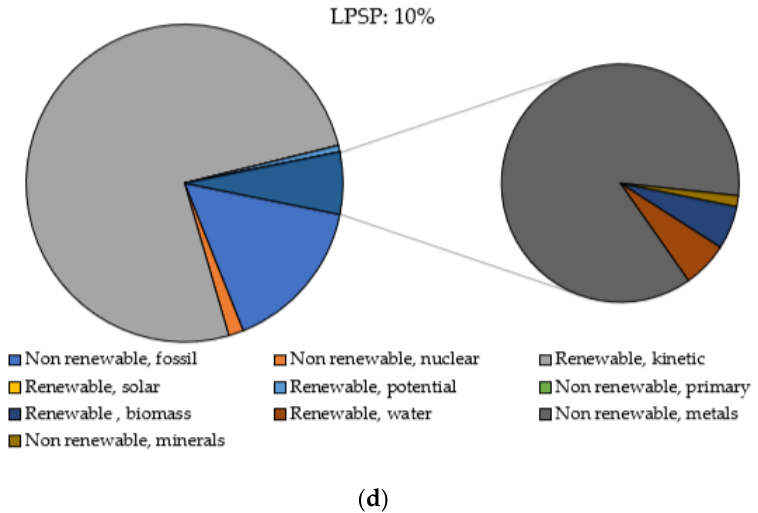
Figure 6. The contribution of impacts categories in developing the total CExD for producing 1 m 3 freshwater by SWROD/WT/BBS when the battery is empty. ( a ) LPSP 0%, ( b ) LPSP 2%, ( c ) LPSP 5%, and ( d ) LPSP 10%. As shown, when system reliability is reduced, a decrease in the contribution of “ re-